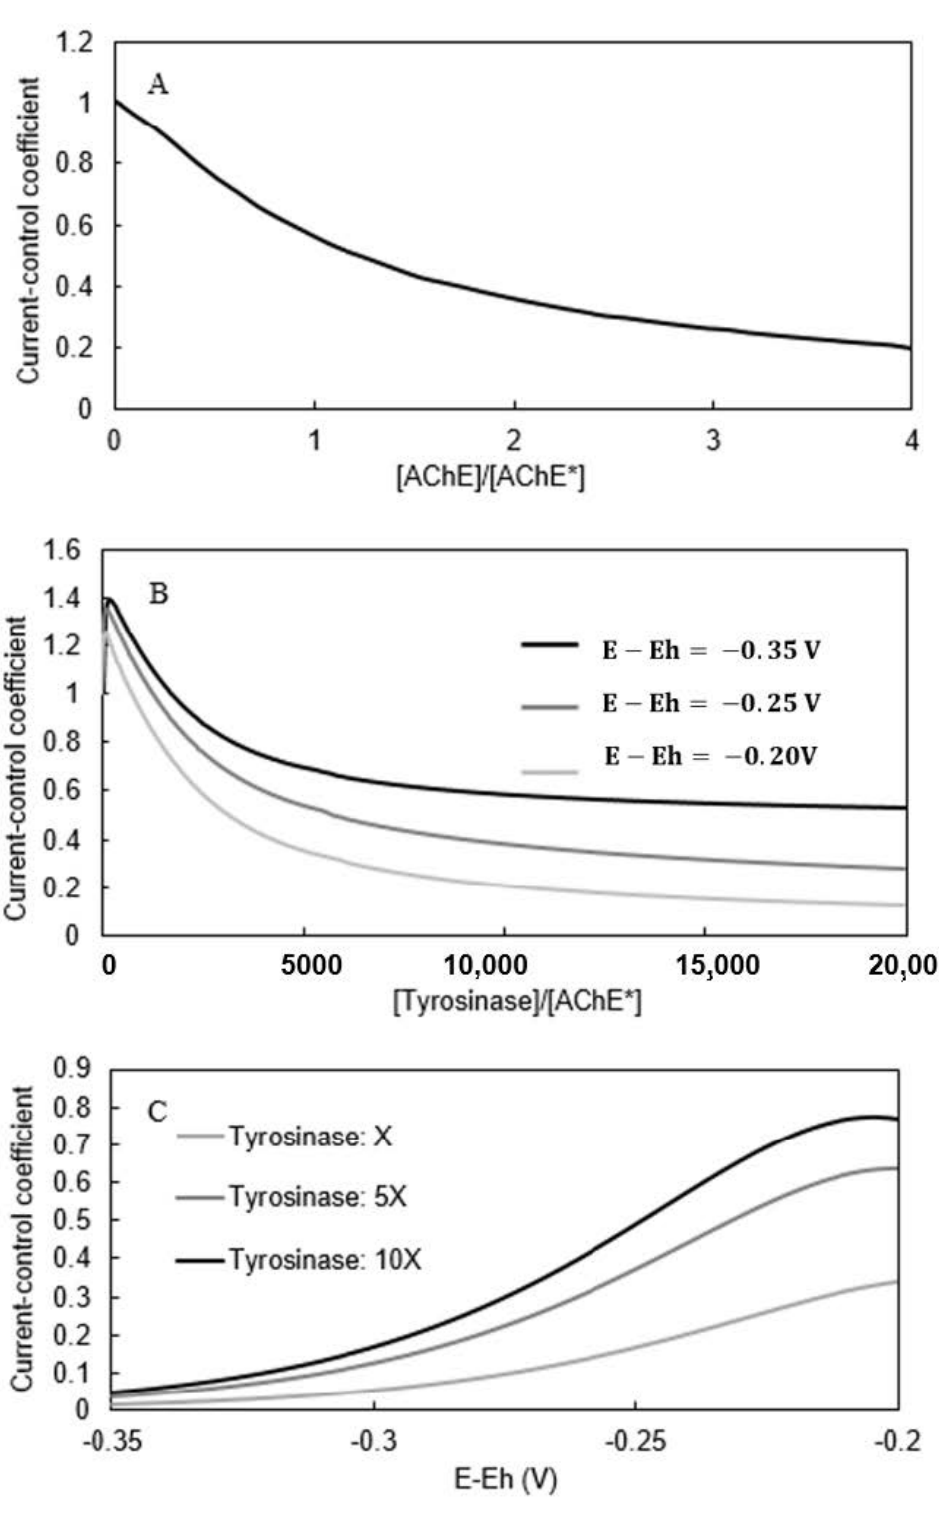
Figure 12. ( A ): Current-control coefficient vs. [AChE]/[AChE*]. ( B ): Current-control coefficient for tyrosinase. Tyrosinase concentration was normalized using [AChE*] = 3 µ M. ( C ): Current-control coefficient based on the electrochemical reaction vs. working-electrode overpotential (E–E h ).